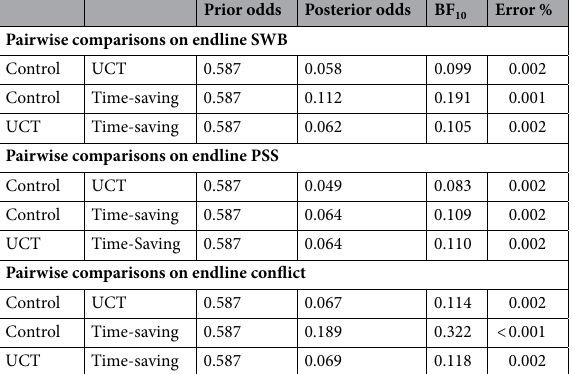
Table 2. Bayesian pairwise comparisons. Individual comparisons are based on a Cauchy prior distribution with an r -scale value of 0.3 for comparisons between the UCT condition and the control condition; 0.5 for comparisons between the pre-registered Time-saving condition and the control condition; and 0.4 for comparisons between the UCT and Time-saving